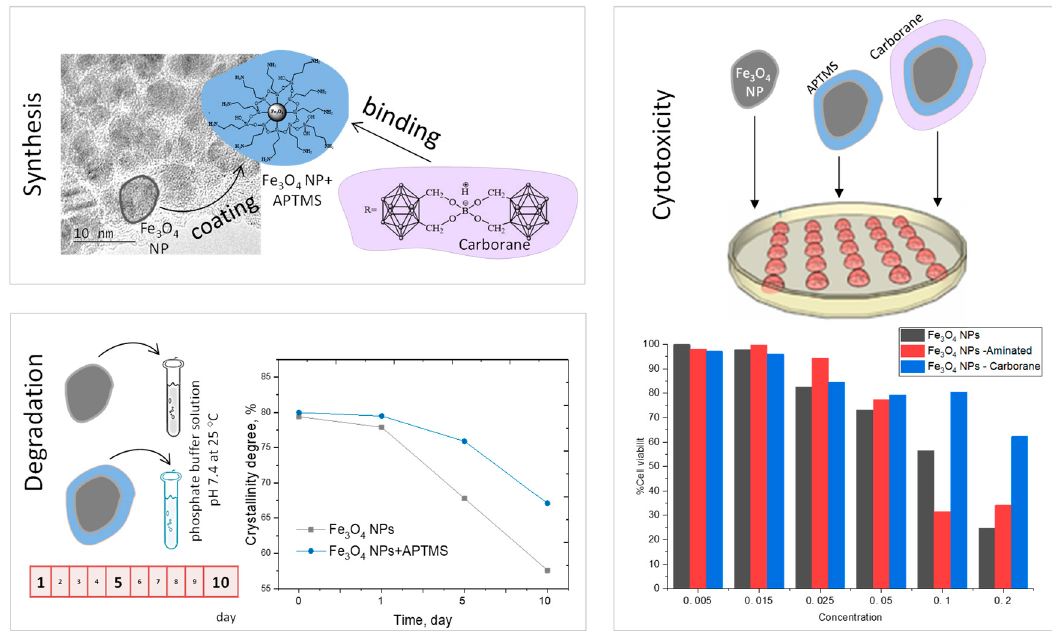
Figure 1. Schematic representation of the study.